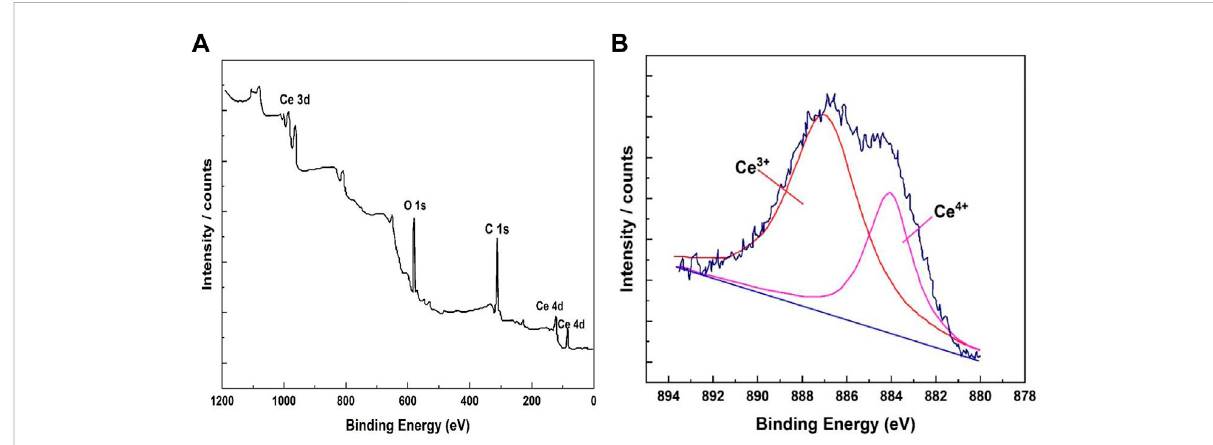
FIGURE 5 XPS band ranges of the cerium coatings. (A) Examination band spectrum. (B) Cerium-based conversion coating peaks.